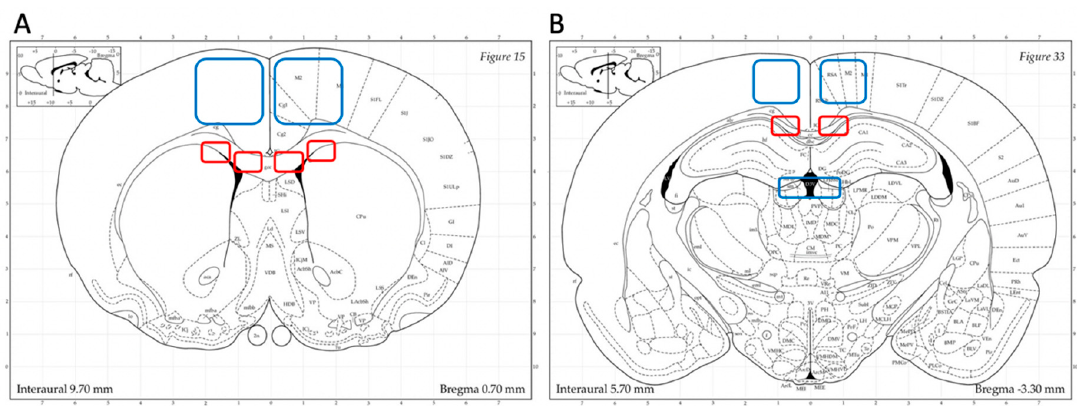
Figure 2. Regions of interest. Highlighted areas represent the systematically analyzed regions throughout the work. ( A ) Frontal brain sections focus on corpus callosum (in this study referred to as CC “subventricular zone” (SVZ) and CC “border”), dorsal cortex. ( B ) Occipital brain sections focus on corpus callosum (in this study referred to as CC “occipital”), dorsal cortex and habenular nuclei. (Atlas source: Paxinos, George and Charles Watson. The rat brain in stereotaxic coordinates: hard cover edition. Access Online via Elsevier, 2006. Online tool by Matt Gadica).